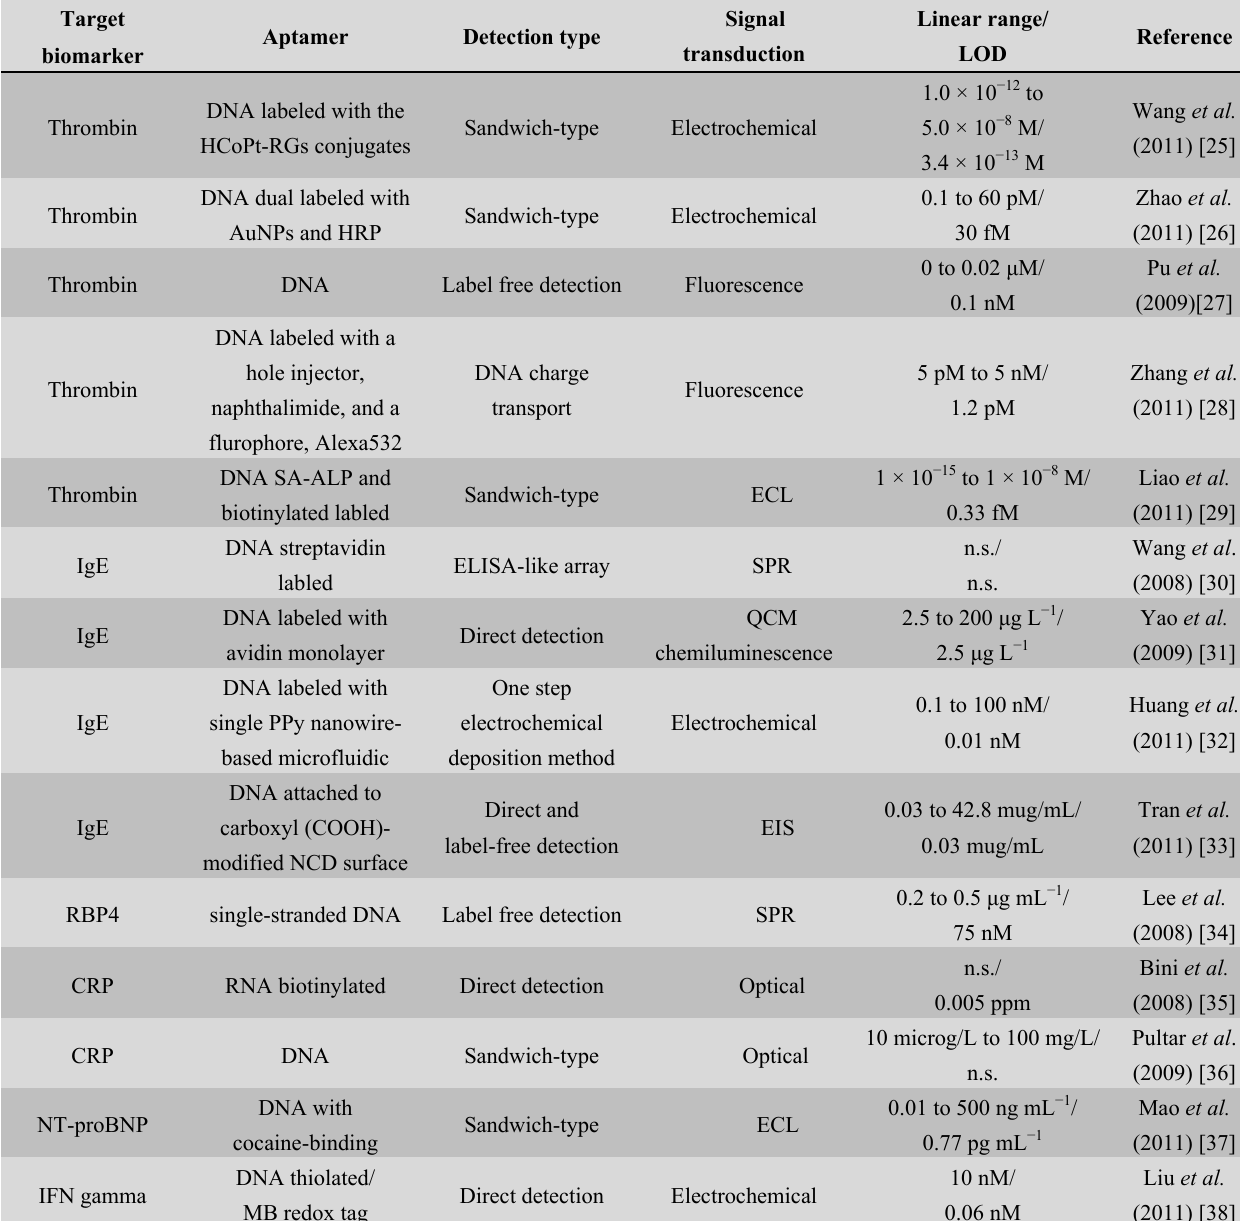
Table 1. Examples of application of aptasensors for detection of